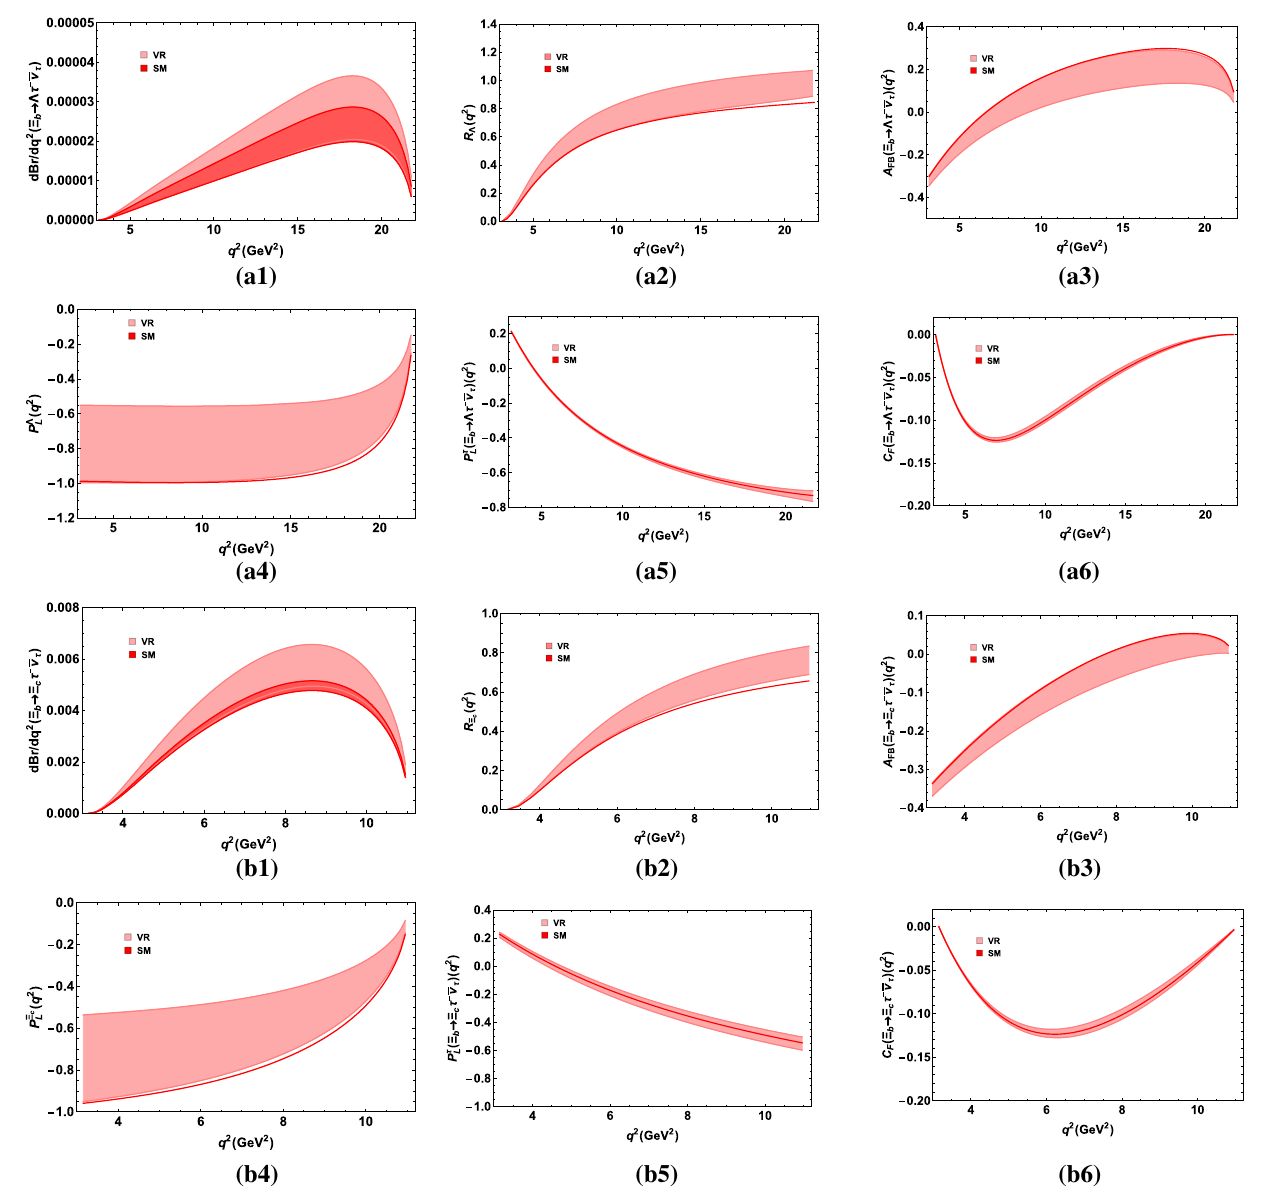
( q 2 ) ( a6 , b6 ) relative to the decays (cid:2) b5 ) and C l F (cid:2) → (cid:2) τ − ¯ ν τ , correspondingly. The bands contain the theoretical b c ( q 2 ) ( a4 , b4 ), P τ ( q 2 ) ( a5 , uncertainty of the CKM matrix elements | V u ( c ) b | L L